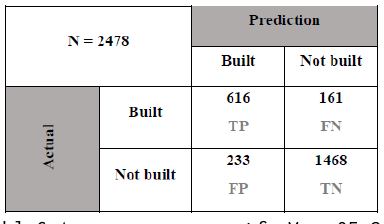
Table 6. Accuracy assessment for Mar. 05, 2017